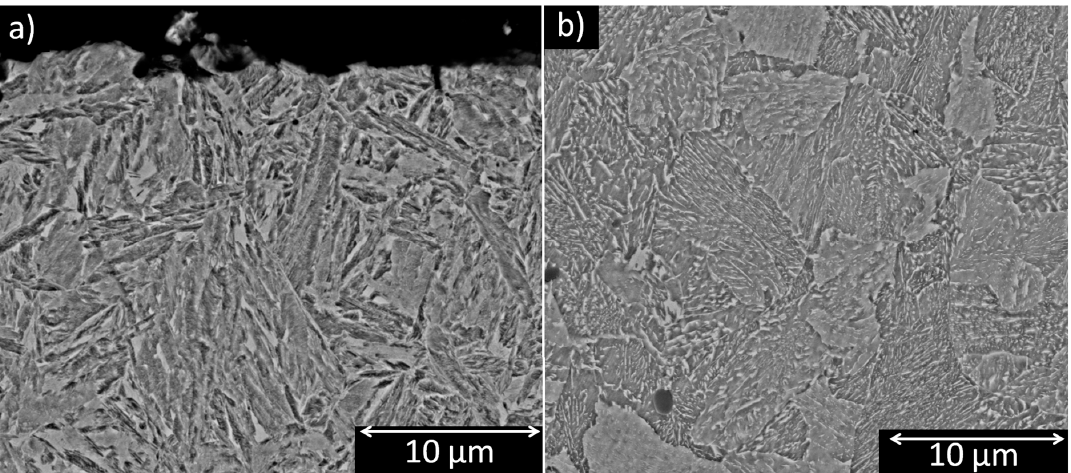
Figure 7. Metallography observed by SEM of 3 s showing tempered martensite at the surface ( a ) and columnar and nodular bainite at the core ( b ).